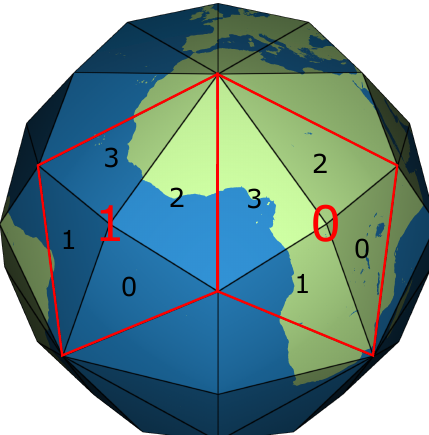
Figure 8. The rhombic triacontahedron (RT) is a subset of the vertices and edges of the DT. Two of the rhombic faces and the rhombus indexing are shown in red. The black indexing corresponds to rhombuses in Figure 10.